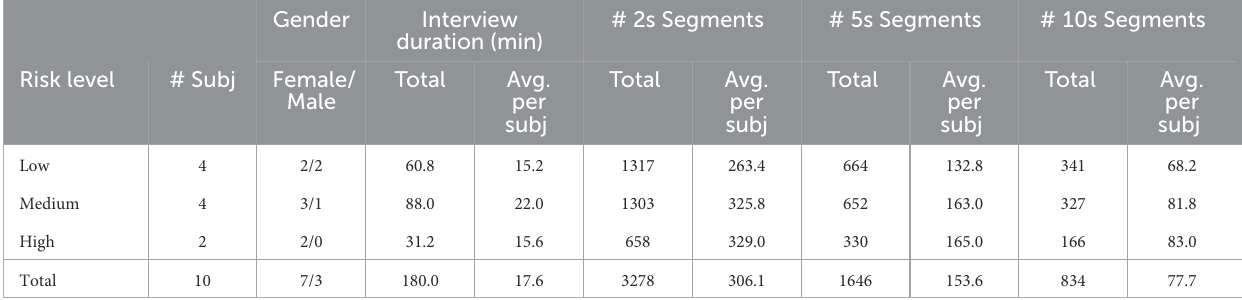
TABLE 1 Details of the sub-dataset used in this work for each suicide risk level (including number of subjects, total and average interview duration, and segments from different window sizes) are as follows). Gender Interview # 2s Segments # 5s duration (min)